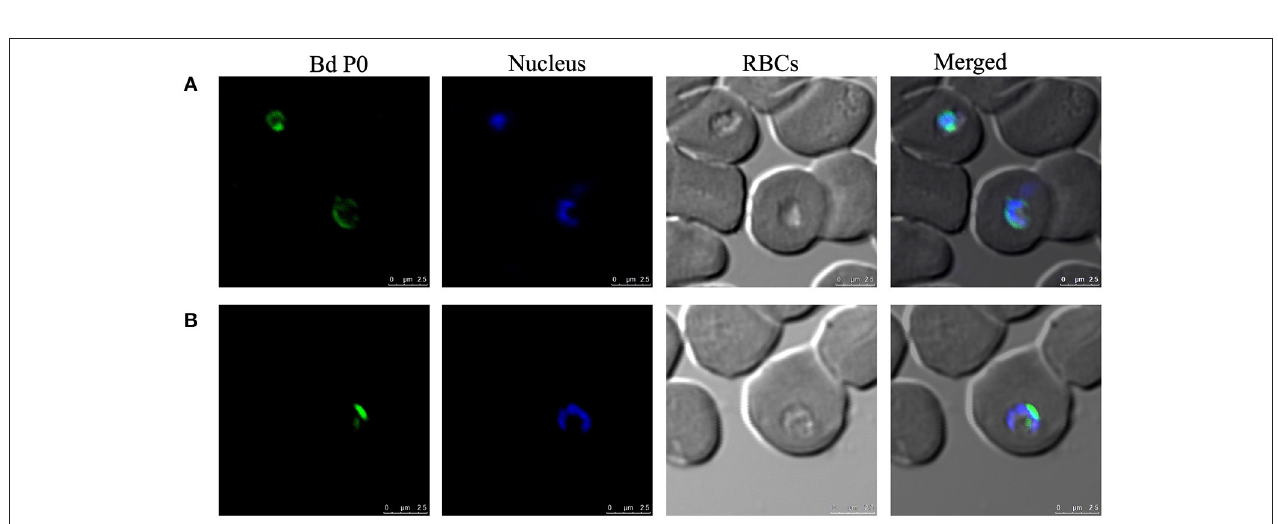
FIGURE 3 | Cellular localization of BdP0 in the erythrocytic stage. Bdp0 in thin blood smears of B. divergens -parasitic RBCs stained with Bdp0-immune sera under confocal laser microscopy. Anti-rBdp0 serum reactivity with single intracellular parasite forms (A) and sequentially dividing forms (B) . Pre-immune and anti-GST sera were used as negative control sera to validate the test (data not shown). Scale bar: 7.5 µ